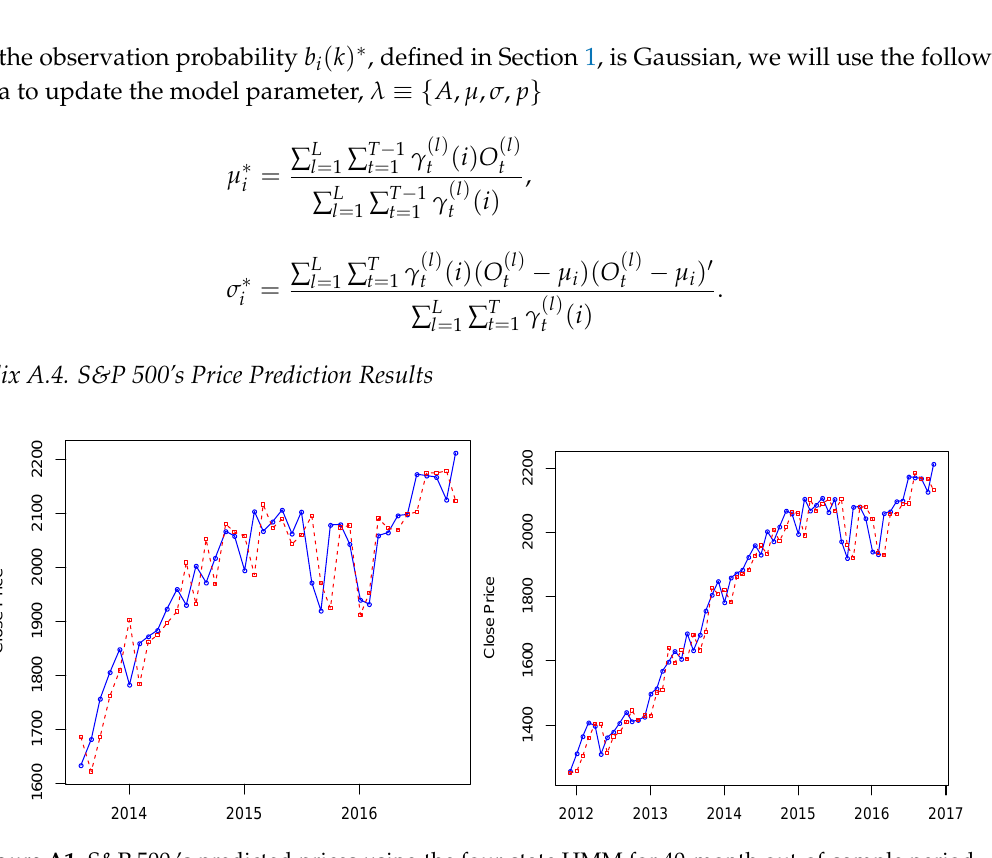
Figure A1. S&P 500 ’s predicted prices using the four-state HMM for 40-month out-of-sample period ( left ) and 60-month out-of-sample period ( right ).